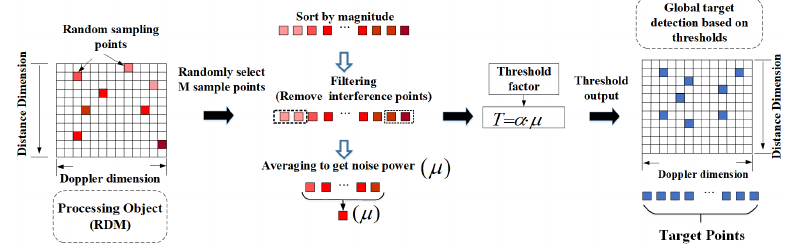
Figure 10. The MC-CFAR processing model.